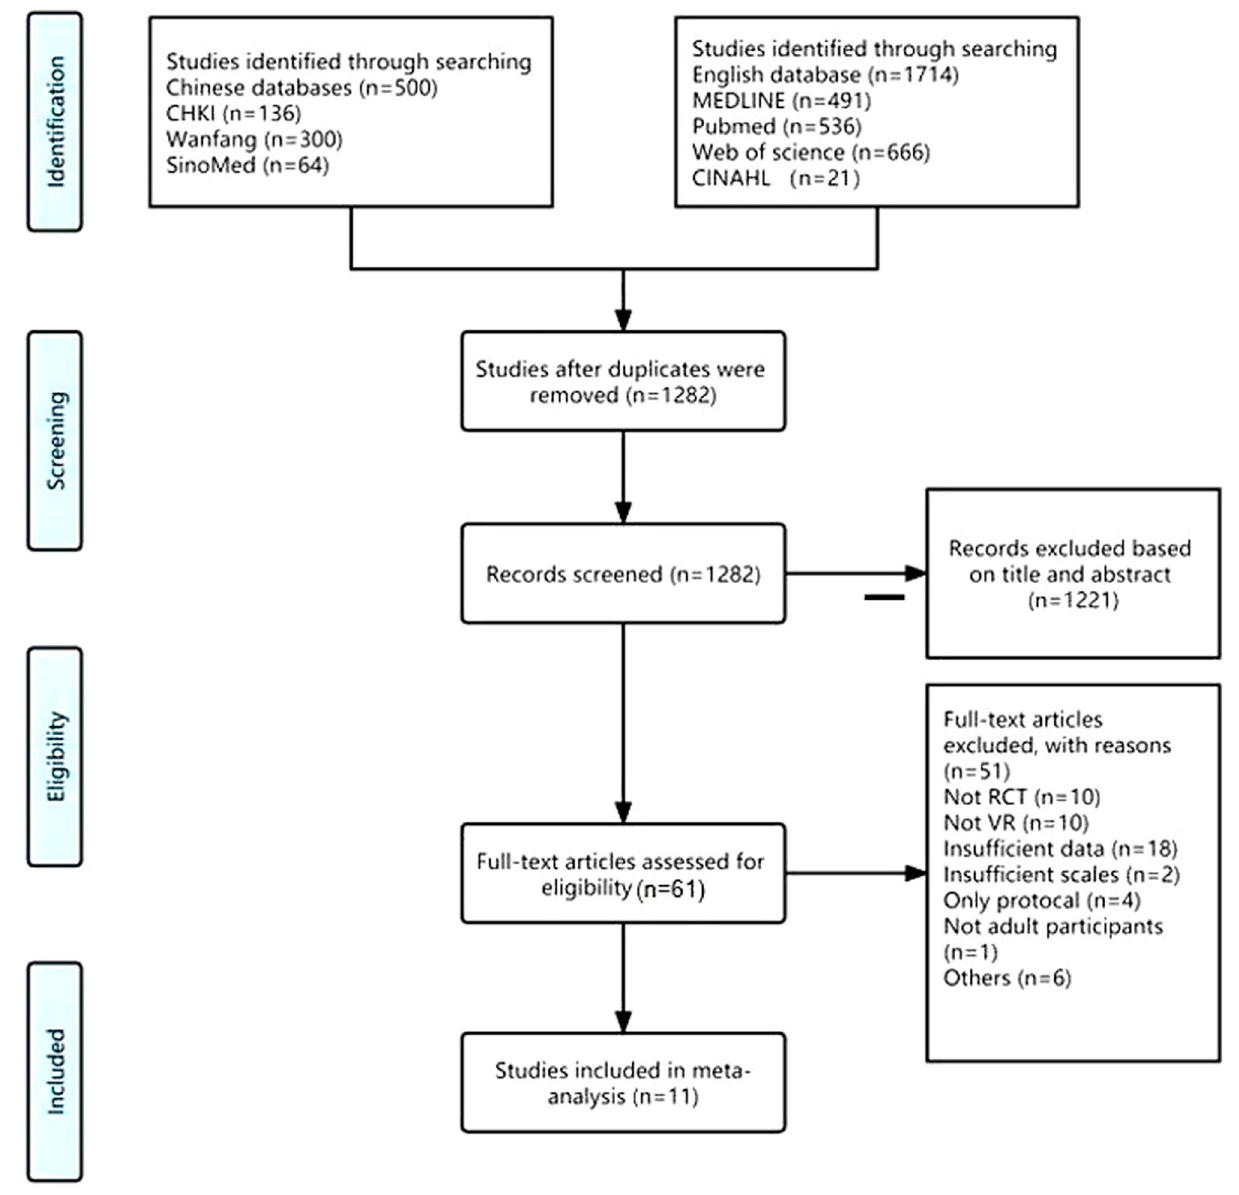
Figure 1. Flow chart of the study selection process in